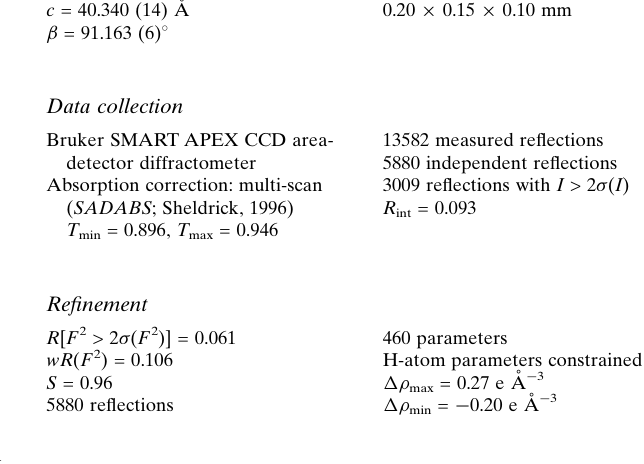
Bruker SMART APEX CCD area- detector diffractometer